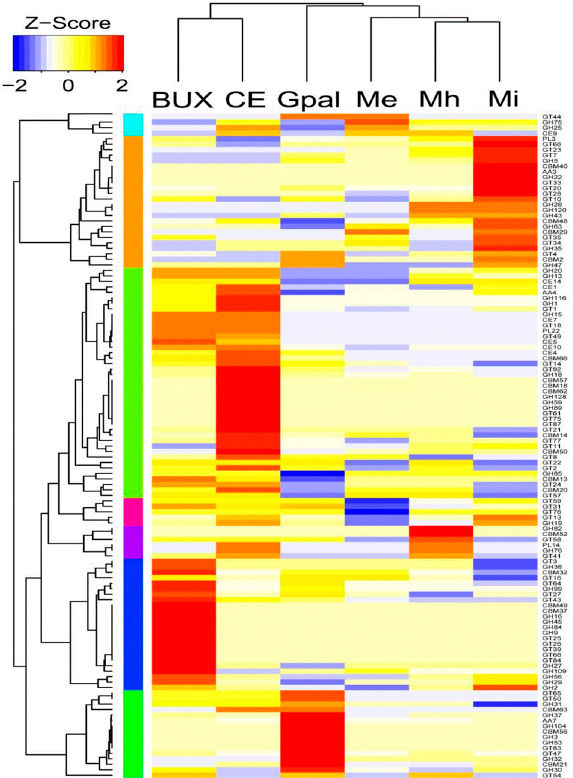
Figure 4. Comparison of the CAZyme repertoires in M. enterolobii and other selected nematode genomes. Enzyme families are represented by their family number according to the carbohydrate-active enzyme database (Available online: http://www.cazy.org/). Over-represented (yellow to red) and under-represented domains (yellow to blue) are depicted as Z-scores for each family. The figure was drawn using the R package heatmap.2. BUX: B. xylophilus ; CE: C. elegans ; Gpal: G. pallida ; Me: M. enterolobii ; Mi: M. incognita ; Mh: M. hapla .